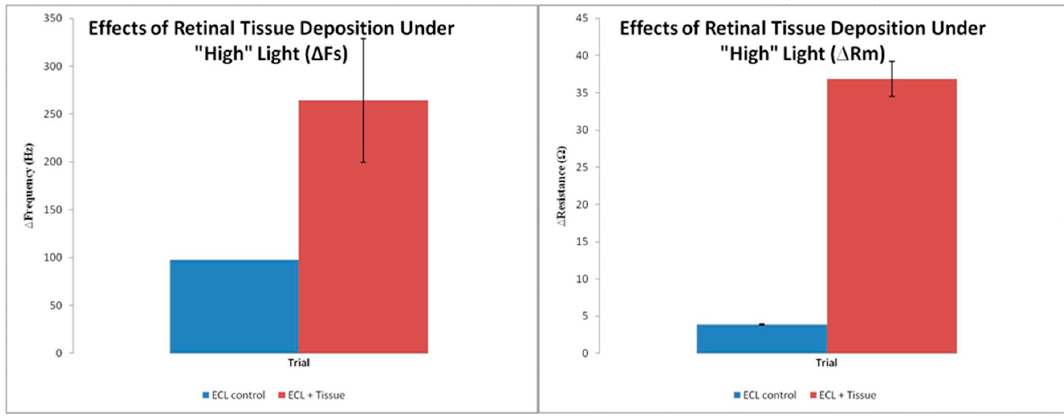
Figure 4. Changes in Fs and Rm for both ECL control experiments and retinal tissue deposited on a TSM Au electrode. High light intensity condition.